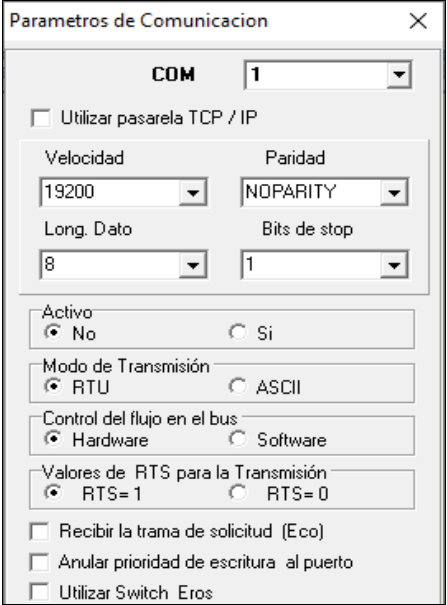
Figure 5: MODBUS MASTER configuration in